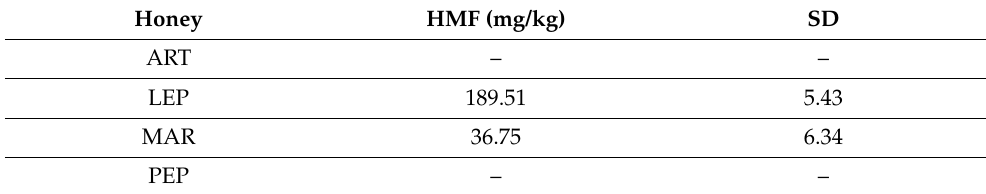
Table 5. 5-Hydroxymethylfurfural (HMF) content in different